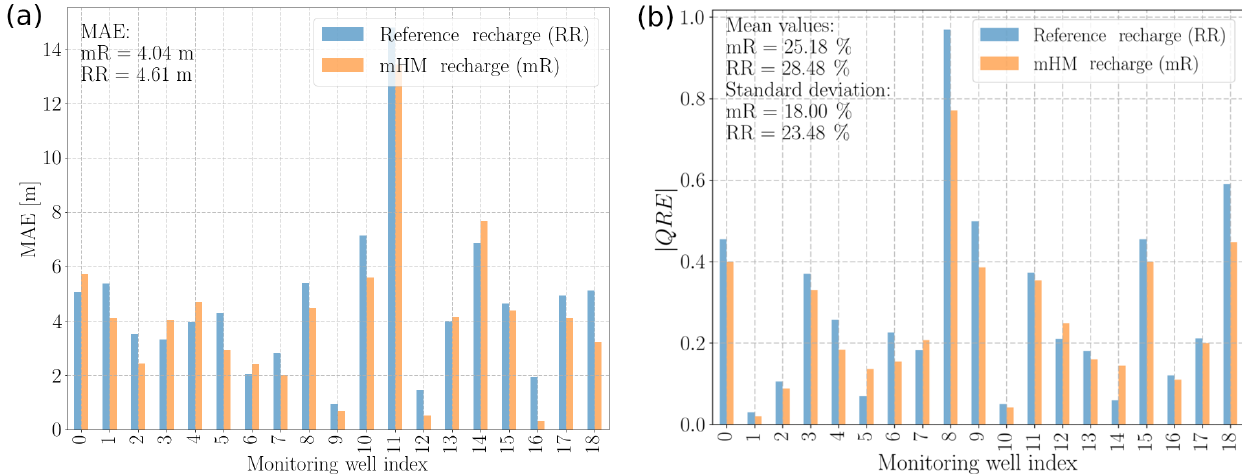
Figure 11. Bar plots of (a) the mean absolute error MAE and (b) the absolute interquartile range error |QRE| in all monitoring wells in two recharge